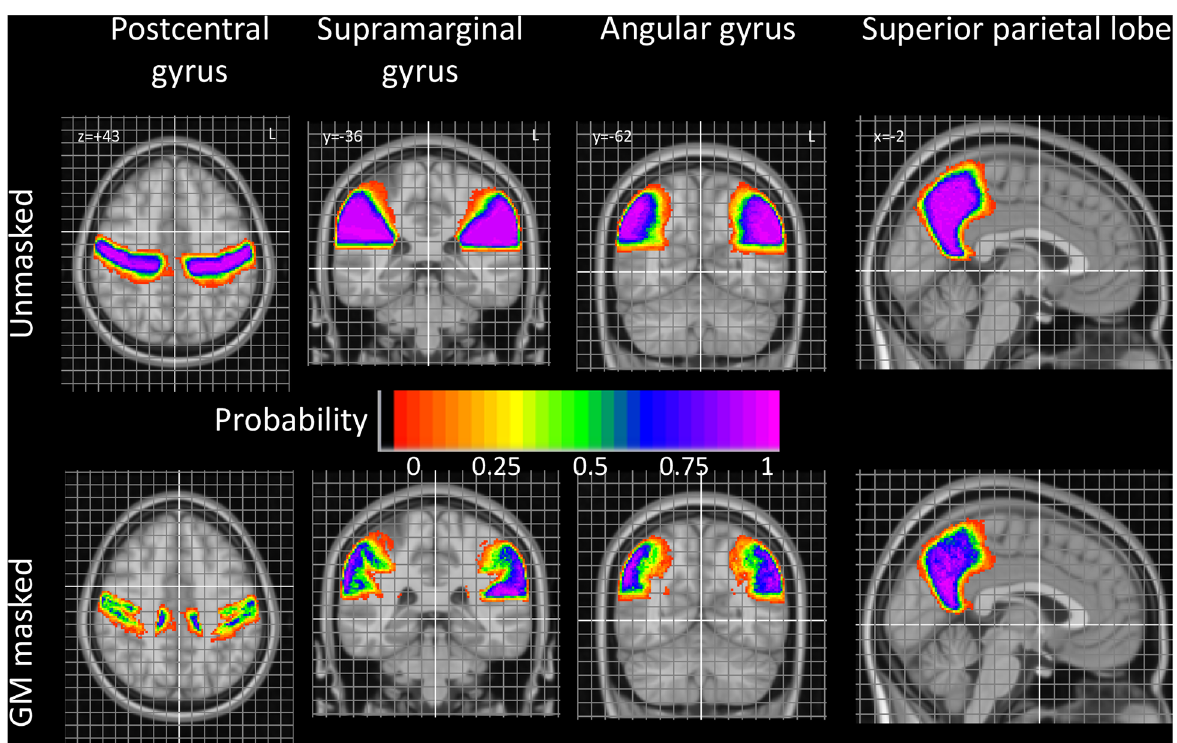
Fig 3. Summarypictures. Taken from detailed, finely spaced probabilisticmaps (for full maps, see S2 File and www.brain- development.org).